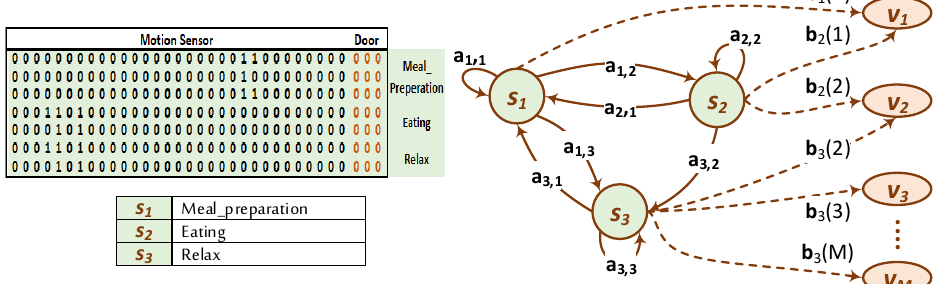
Figure 2. Paradigm #1: Annotation gaps are removed completely from the training